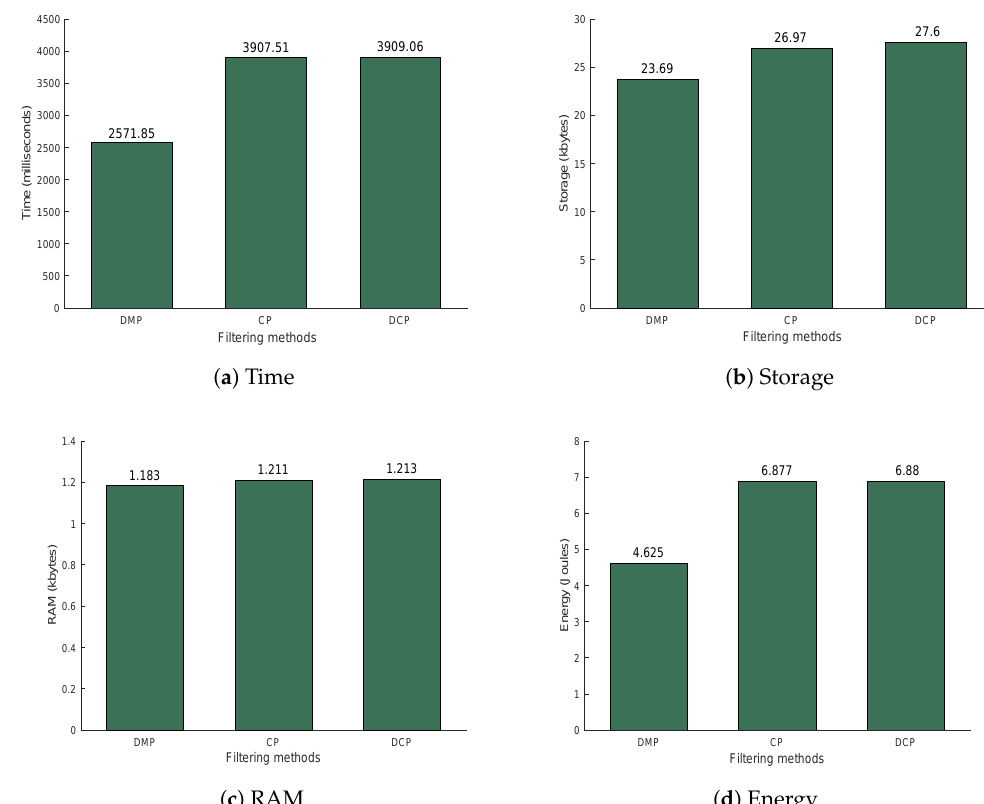
Figure 16. Resource consumption of DMP, CP and DCP verification processes in